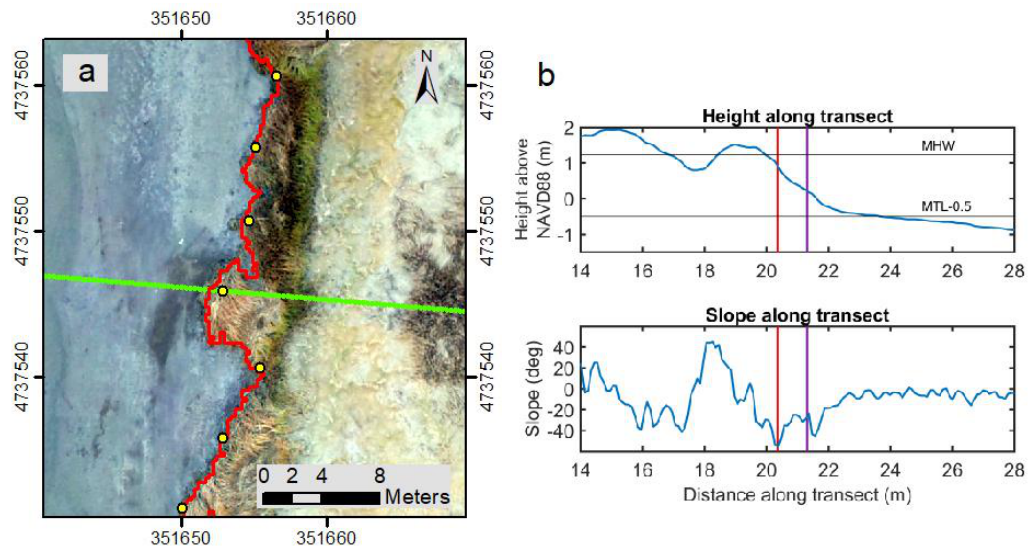
Figure 8. An example of a transect where the scarp and unvegetated / vegetated line disagree in Plum Island, MA. ( a ) UAS imagery, yellow dots: Marsh scarp from MEED, red line: Unvegetated / vegetated line from MEIP, green line: Sample transect shown in Figure 8b; ( b ) UAS elevation data from the sample transect shown in Figure 8a. Top: Elevation along transect, the horizontal black lines indicate MHW and (MTL - 0.5 meters). Bottom: Slope along transect. Red line: The marsh scarp from MEED, purple line: Unvegetated / vegetated line from MEIP. The scarp and unvegetated / vegetated line are 0.97 meters apart; the two local maxima (in magnitude) of slope (between MHW and MTL - 0.5 meters) are 1.1 meters apart.